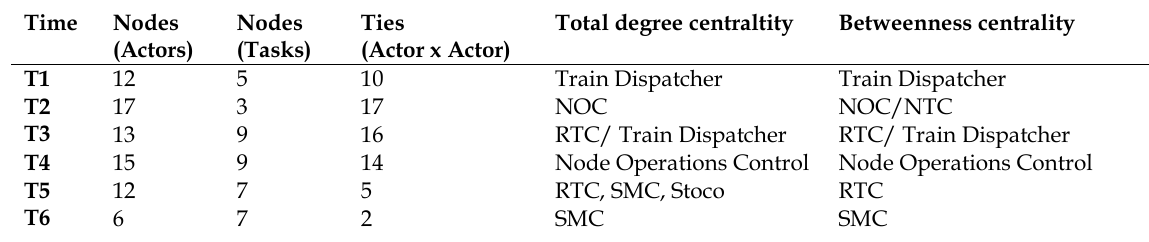
Table 6. Most central actors per time